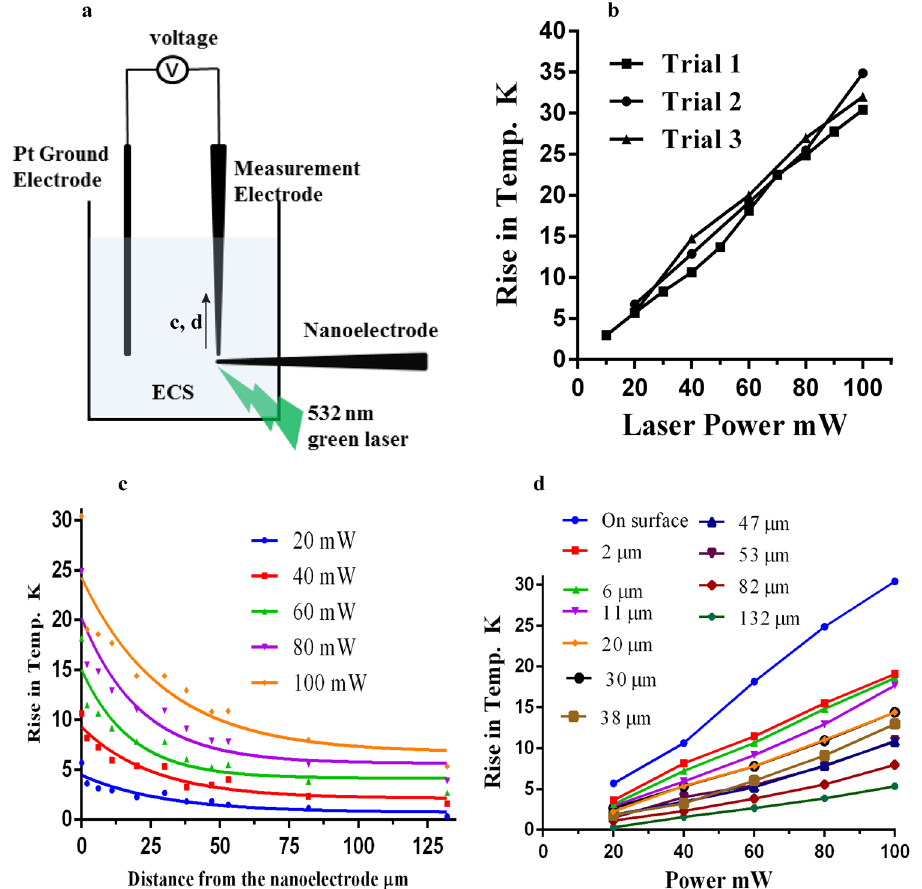
Figure 3. Localized temperature rise measurements. ( a ) Schematic diagram of the plasmonic temperature rise measurements on/near the surface of the nanoelectrode. The experiments were performed in a 35 mm Petri dish filled with extracellular solution (ECS). The measurement electrode was a glass micropipette filled with ECS. A change in resistance was measured in response to a 532 nm green laser focused on the nanoeletrode tip. The resistance vs temperature function was utilized to get the temperature values. ( b ) The rise in temperature on the surface of the nanoelectrode has a linear relation with laser power. ( c ) The temperature decays exponentially with the distance away from the nanoelectrode. The different colors indicate the different laser power settings. The results were fitted to the equation: T = (T o − C) * exp ( − kx) + C [parameter values are provided in Supplementary Table 1]. ( d ) Plasmonic temperature rise versus laser power at different distances away from the